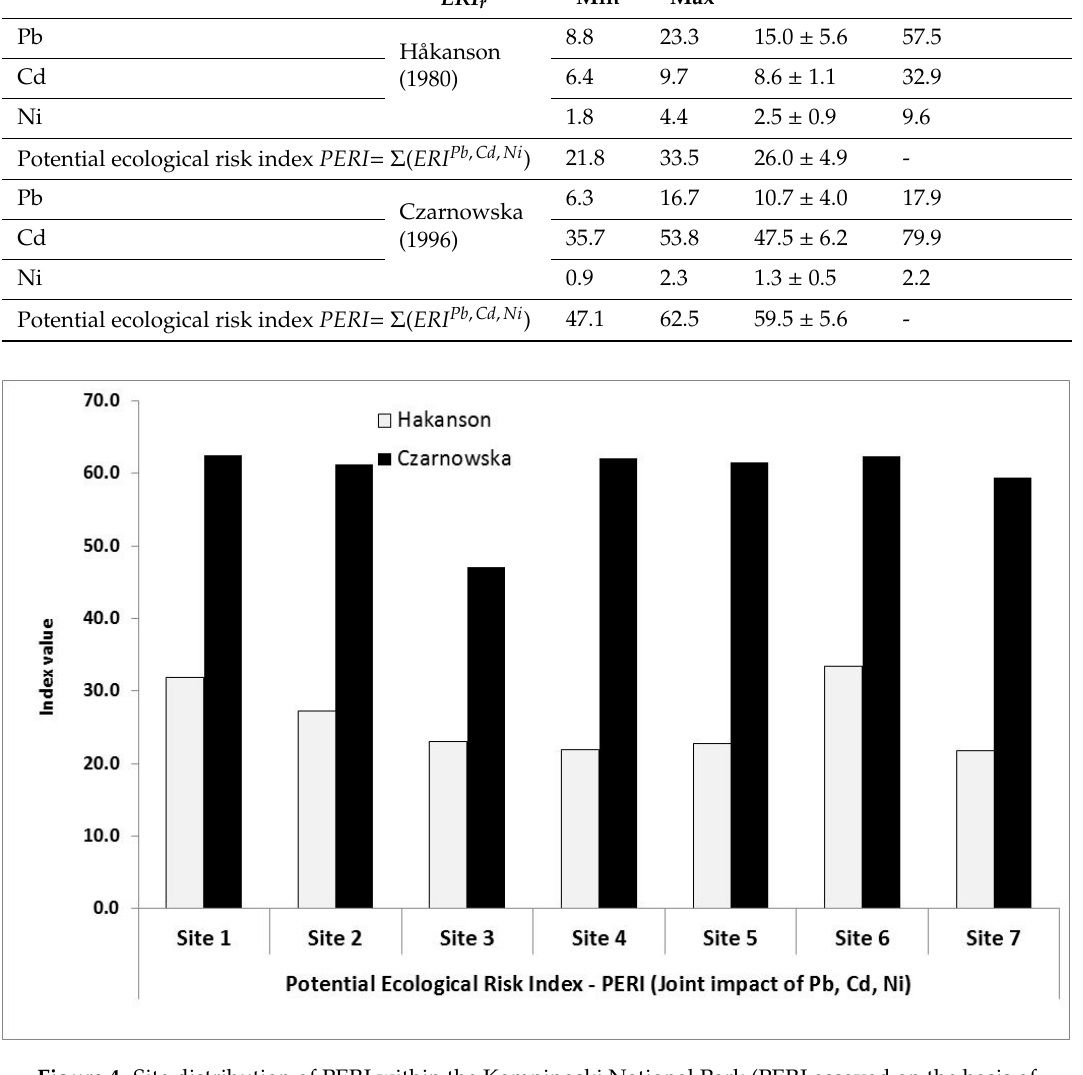
Figure 4. Site distribution of PERI within the Kampinoski National Park (PERI assayed on the basis of Håkanson and Czarnowska background values, Table 1).